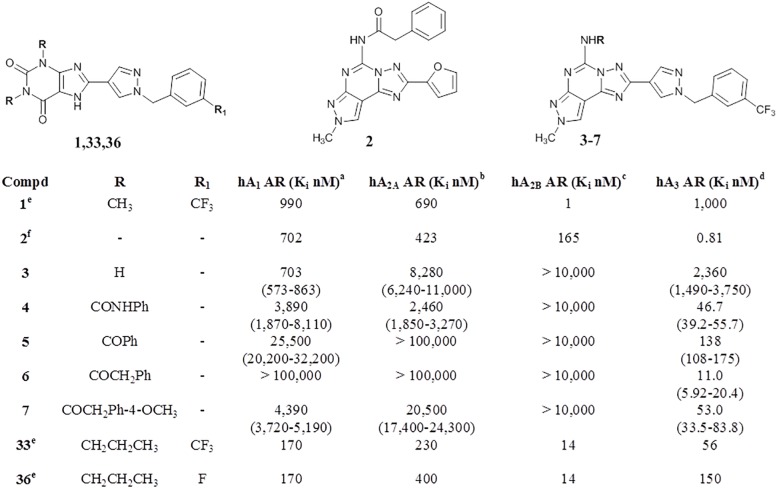
Structures and binding profile of reference (1,2,33,36) and synthesized compounds (3–7).
aDisplacement of specific [3H]-CCPA binding at hA1 ARs expressed in CHO cells, (n = 3–6). bDisplacement of specific [3H]-NECA binding at hA2A ARs expressed in CHO cells. cKi values of the inhibition of NECA-stimulated adenylyl cyclase activity in CHO cells expressing hA2B ARs. dDisplacement of specific [3H]-HEMADO binding at hA3 ARs expressed in CHO cells. Data are expressed as geometric means, with 95% confidence limits. edata from ref. [22]. fdata from ref. [32].